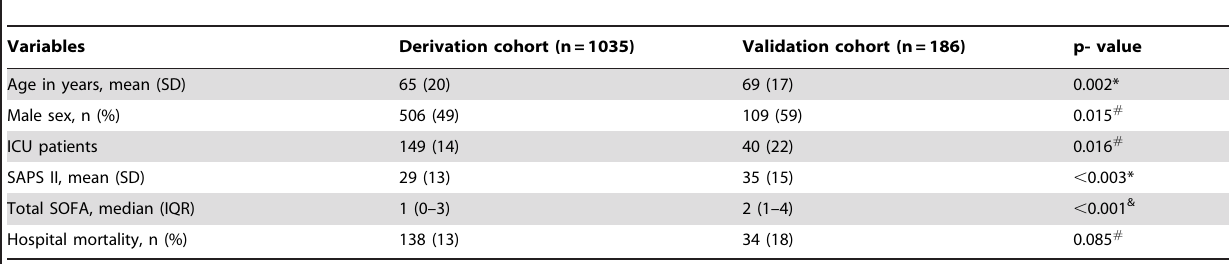
Table 1. Demographic and clinical characteristics of patients in the derivation and validation cohorts.